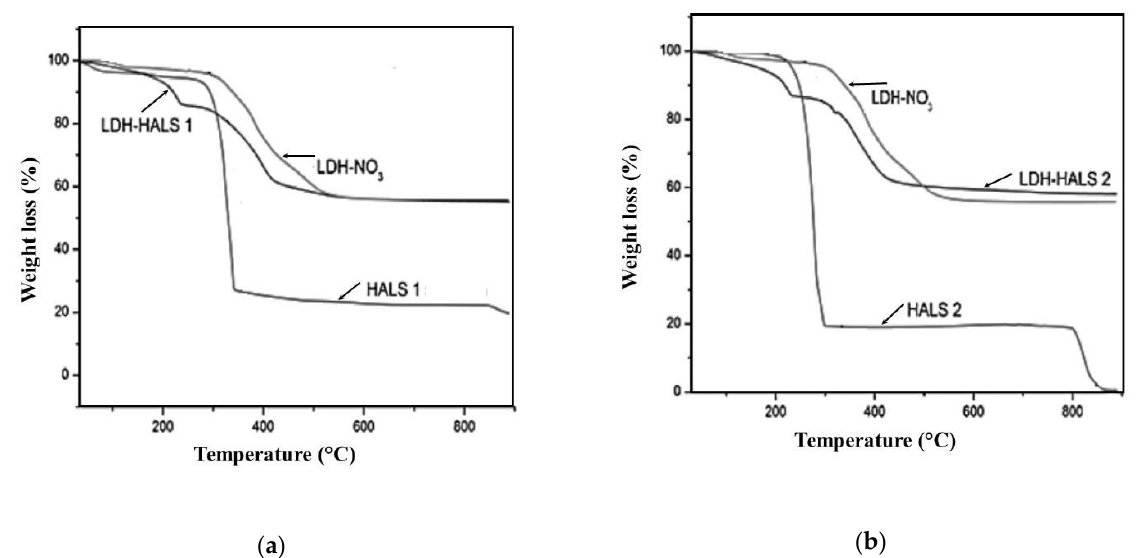
Figure 4. TGA curves of ( a ) LDH-HALS1 and neat HALS1 and ( b ) LDH-HALS2 and neat HALS2 in comparison to the curve of LDH-NO 3.